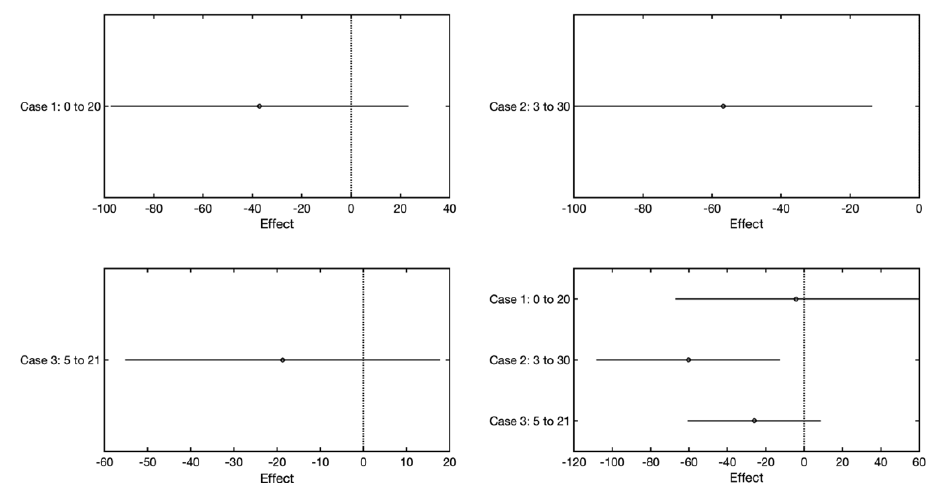
Figure 10. Comparison of regression models for individual use case types.